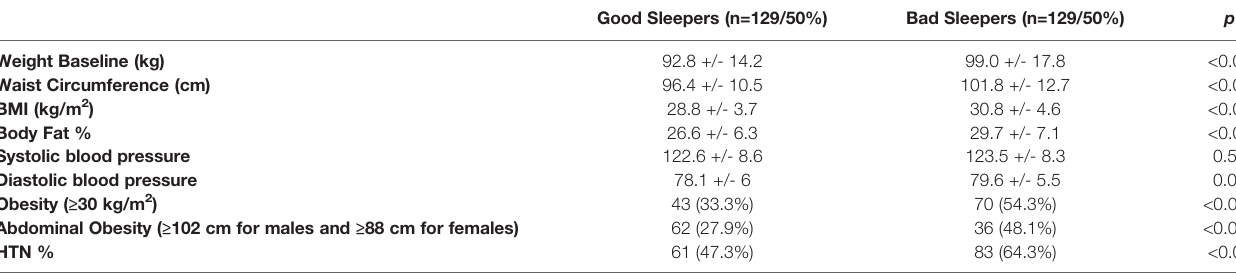
TABLE 2 | Anthropometrics and hypertension in “ good ” and “ bad ” sleepers as classi fi ed using the SQI.